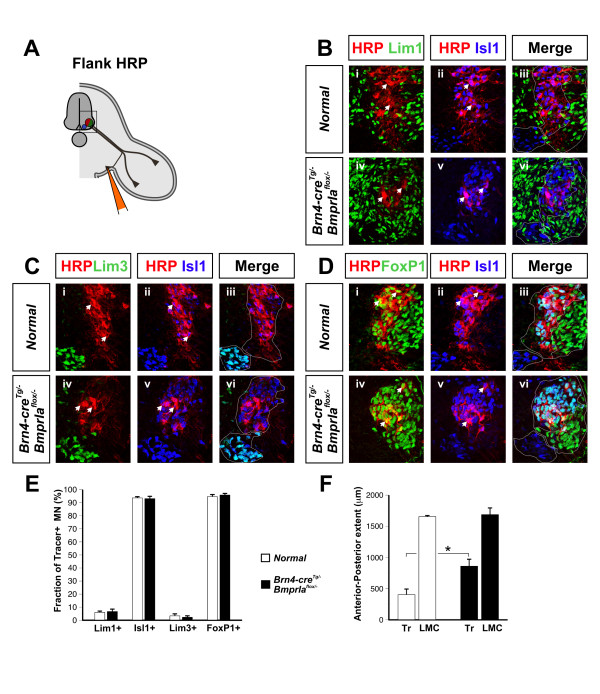
Medial LMC axons innervate the BmprIaflox/- ventral flank mesenchyme. The columnar origin of neurons innervating the ventral flank mesenchyme at E13.5 was defined by HRP or RDA retrograde labeling. (a) Schematic of experiments shown in (b-d). (b) Flank nerves originate from medial LMC neurons in normal and mutant embryos, as Isl1+ medial LMC cells are readily HRP-labeled in triple coimmunostained sections. (c) Flank nerves in normal and mutant do not originate from medial MMC cells, as Lim3+ medial MMC cells are rarely HRP+ in triple coimmunostained sections. (d) Flank nerves in normal and mutant originate from medial LMC but not medial MMC as coimmunostained HRP+ Isl1+ FoxP1+ medial LMC cells were readily detected. In (b-d), upper panels are controls and lower panels are BmprIaflox/- mutants. Arrowheads indicate representative HRP+ neurons colabeled with nuclear markers and dotted lines in (b-d) indicate columnar division outlines. (e) Quantification of labeling data shows that axons projecting to ventral flank mesenchyme in normal and BmprIaflox/- mutant embryos are from Isl1+ Lim1- Lim3- FoxP1+ medial LMC neurons. The percentages of HRP+ or RDA+ cells were as follows. Isl1+ Lim1-: normal, 94 ± 1.2, n = 5 embryos, 648 neurons counted; mutant, 93 ± 2.1, n = 5, 388 neurons; P = 0.83. Lim3+: normal, 3.5 ± 1.8, n = 5, 515 neurons; mutant: 2.4 ± 1.4, n = 4, 283 neurons; P = 0.62. FoxP1: normal, 95 ± 1.5, n = 5, 479 neurons; mutant, 96 ± 1.5, n = 4, 262 neurons; P = 0.63). (f) Anterior-posterior length of the LMC is similar in normal and mutant E13.5 embryos, while the extent of the LMC labeled from the ventral flank is significantly increased in mutant embryos. LMC lengths (Isl1+/Hb9-GFP+ sections) were: normal, 1,658 ± 23 μm, n = 6 embryos; mutant, 1,690 ± 113 μm, n = 5; P = 0.745. Tracer extents (HRP+ or RDA+ sections) were: normal, 407 ± 96 μm, n = 5 embryos; mutant, 864 ± 116 μm, n = 5; P = 0.008.